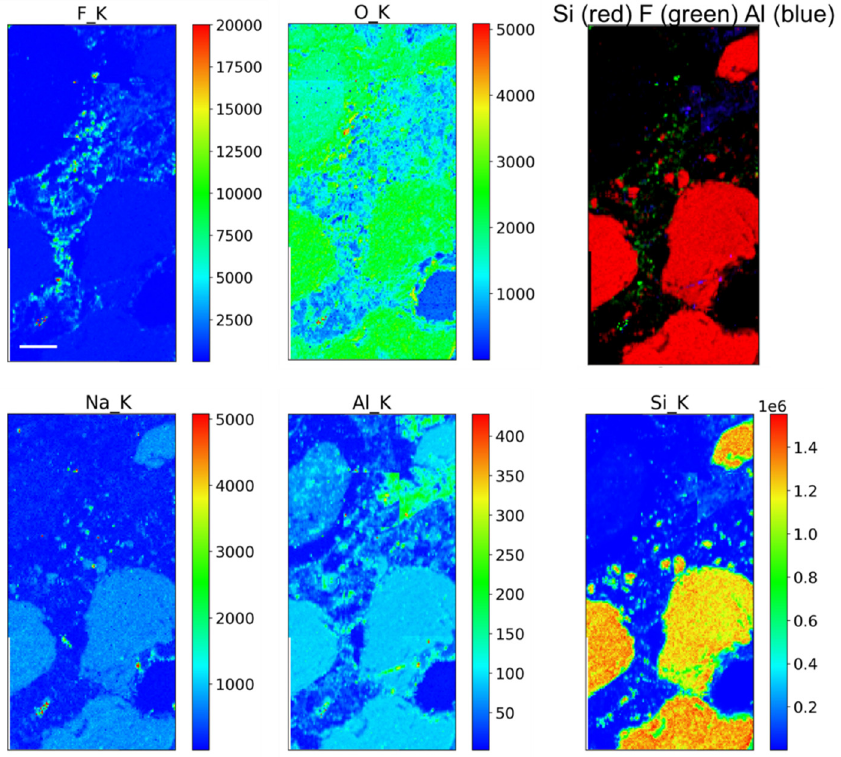
Figure 4. High-energy elemental XRF maps (acquired at 2 keV with 2 µm diameter beam size, over an area of 240 × 480 µm 2 ) of the sample treated with Fluoline HY. The third map shows RGB correlation images for 3 different chemical elements, highlighting their possible co-localization. The scale bar is 50 µm.